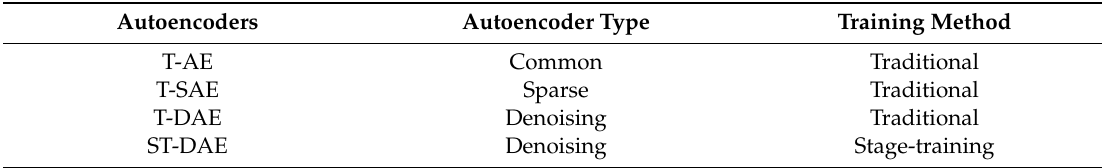
Table 1. Description of the control